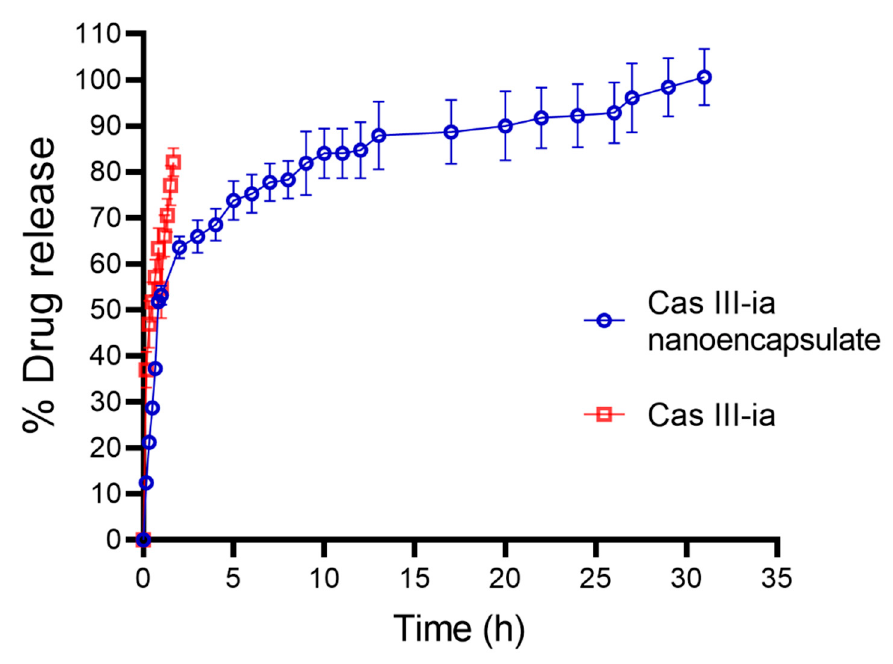
Figure 7. Drug release profile of nanoencapsulated CasIII-ia (blue line) and profile of free CasIII-ia (red line) ( n = 3).